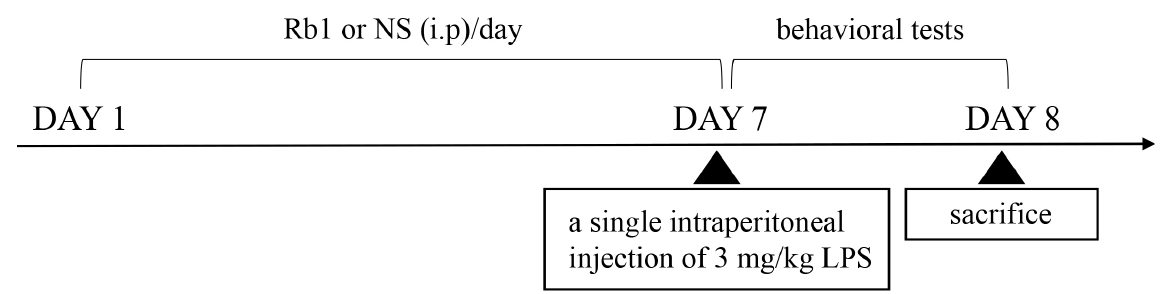
Fig. 1. The experimental design. ICR mice were intraperitoneally (i.p.) injected with 20 or 40 mg/kg Rb1 or saline for 7 consecutive days. On the 7th